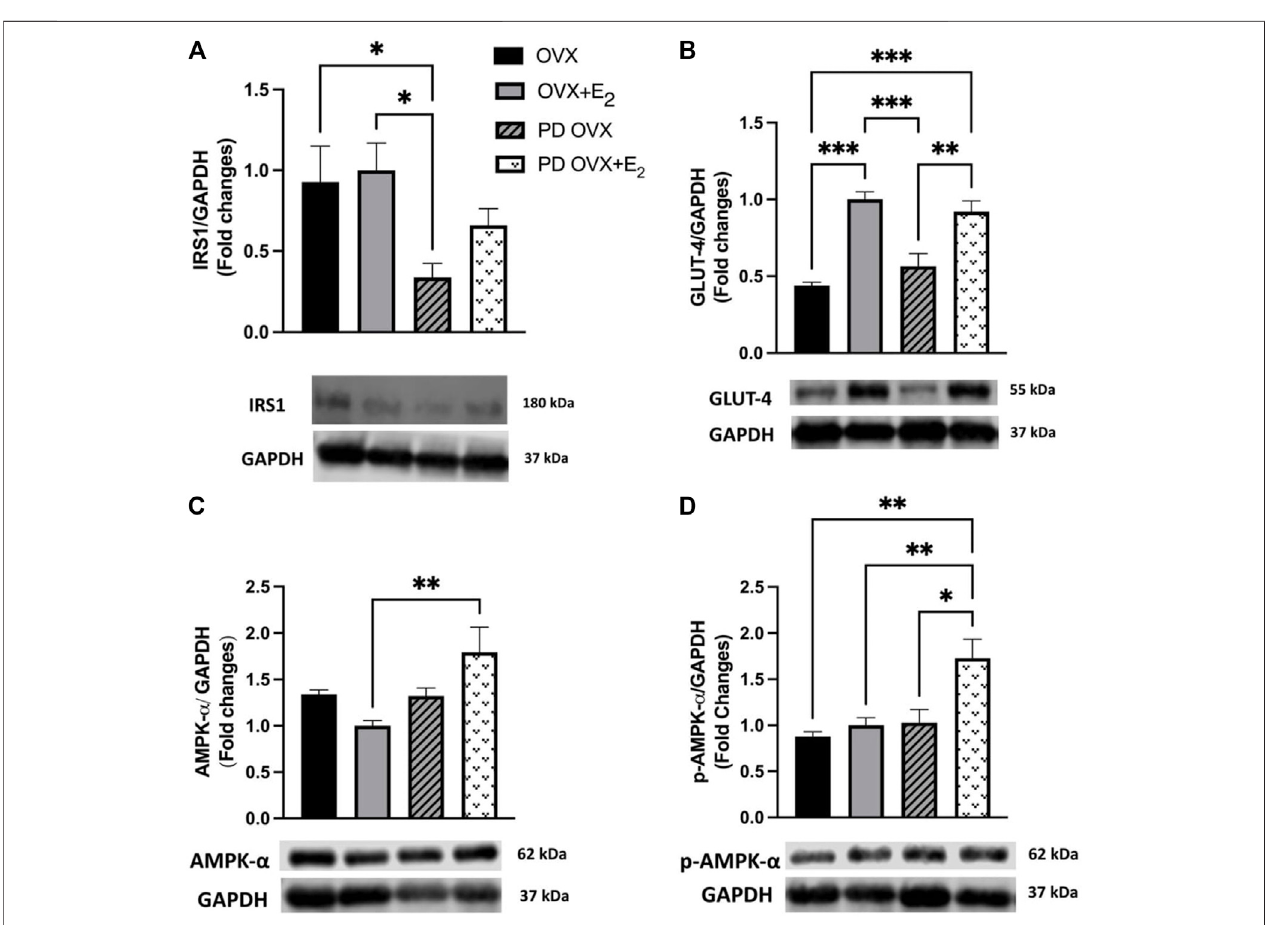
FIGURE 2 | Western blot analysis of (A) IRS1 (B) GLUT-4 (C) AMPK- α (D) p-AMPK- α expression in skeletal muscle of ovariectomized (OVX) and E 2 replaced (OVX+E 2 ) control and prediabetic (PD) rats. Protein level was quanti fi ed by densitometry and normalized to corresponding GAPDH. Values are represented as mean ± SEM.Eachbarrepresentsthevaluesobtainedfrom n =4 – 5animalspergroup.Representativebandsoftargetandhousekeepingprotein(GAPDH)wereshownfromthe samemembranes.Cappedlinesindicatesigni fi cantdifferencesbetweentwogroups(* p < 0.05,** p < 0.01,*** p < 0.001),analyzedusingone-wayANOVAfollowed by Tukey ’ s post hoc test. IRS1, insulin receptor substrate 1; GLUT-4, glucose transporter-4; AMPK- α , AMP-activated protein kinase- α ; p-AMPK- α , phosphorylated- AMP-activated protein kinase- α .